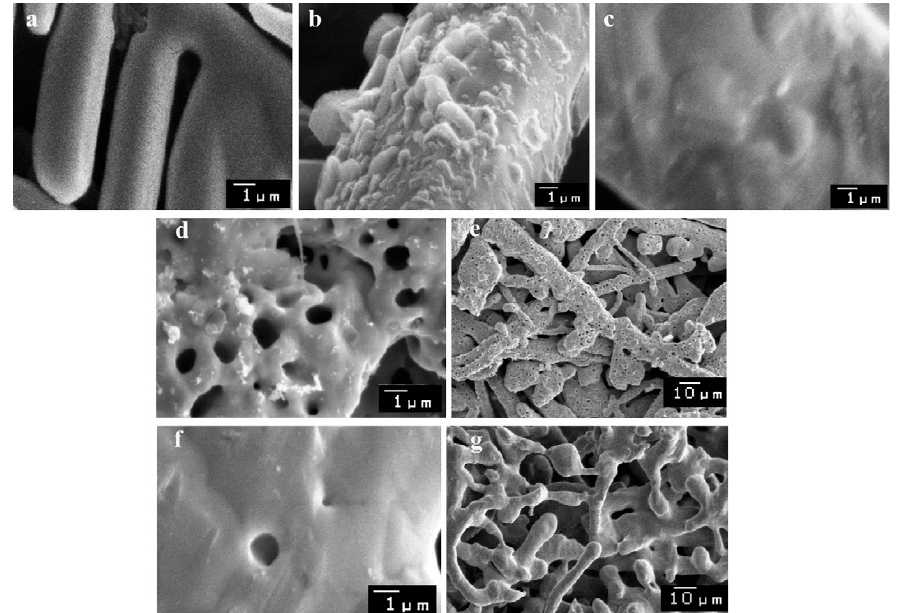
Figure 8. SEM images of the electrolytic silver catalysts before ( a – c ) and after ( d – f ) the catalytic experiments (at 550 °C for 60 min): ( a ) unpromoted Ag catalyst; ( b ) after promoting by phosphoric acid; ( c ) P-containing catalyst after annealing at T = 650 °C for 3 h in the air; ( d , e ) unpromoted Ag catalyst after catalytic reaction; ( f , g ) P-containing Ag catalyst after catalytic reaction. Reprinted with permission from reference [84]. Copyright 2008 Elsevier.